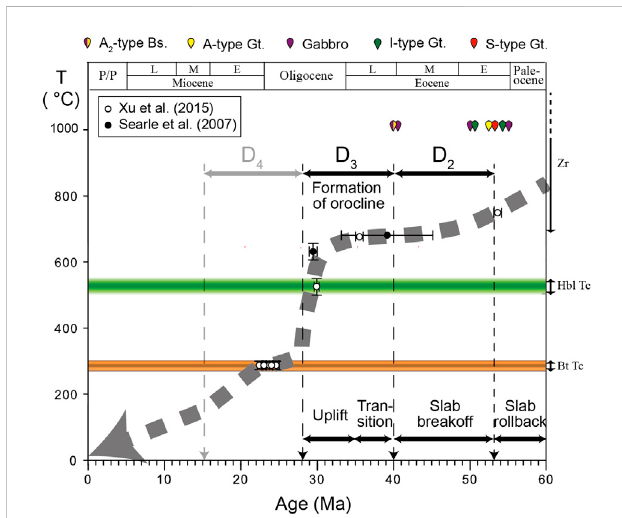
FIGURE 9 Reconstructed cooling path according to published ages and their closure temperature/thermal conditions. The ages are zircon U-Pb dating ages with Ti-in-zircon thermometry, the Ar – Ar ages of hornblende and biotite (Xu et al., 2015), and monazite U-Pb ages with the garnet – biotite geothermometer from the Mogok metamorphic belt (Searle et al., 2007). The different color symbols at 1,000 ° C mark different magmatic periods of I-type, S-type, A-type, and gabbro in the Tengchong block. Combining the cooling path, the tectonic evolution, and medium-to-high-grade metamorphism conditions for D 2 and D 3 , we considered that D 2 occurred during 53 – 40 Ma when the extensional setting caused the slow cooling of the rock as leucogranite formed. D 3 occurred during 40 – 28 Ma when the compressional setting produced a thrust fold belt followed by rapid cooling with the uplift, which is D 4 . The closure temperatures(T C )ofdifferent mineralsused are as follows: T CHbl for hornblende (500 ° C – 550 ° C; Harrison and McDougall, 1982), T CBt for